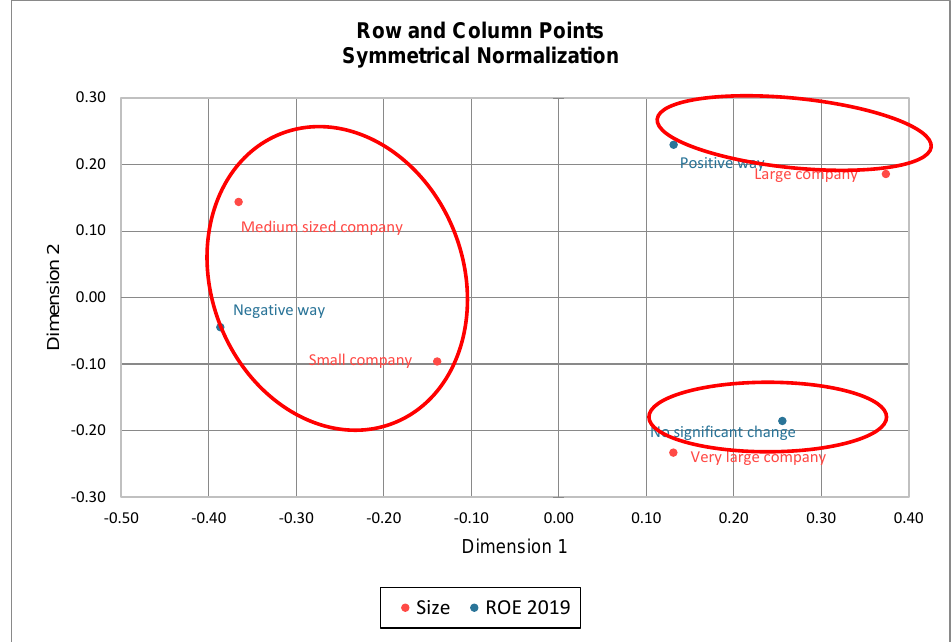
Figure 9. Correspondence map for ROE indicators in 2019 and enterprise size categories. Source: own research.